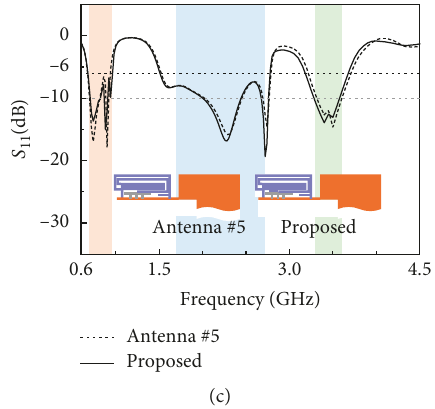
Figure 2: Simulation results of the S